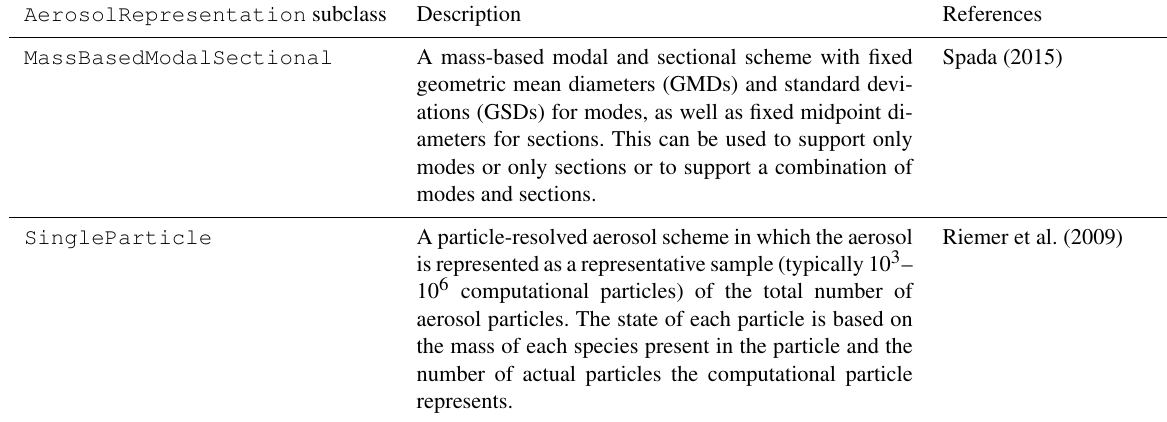
Table 6. Current implementations of the AerosolRepresentation base class. Note that many details of these aerosol representations (e.g., number of modes or sections, mode and/or bin GMD or GSD, number of computational particles) can be easily configured at